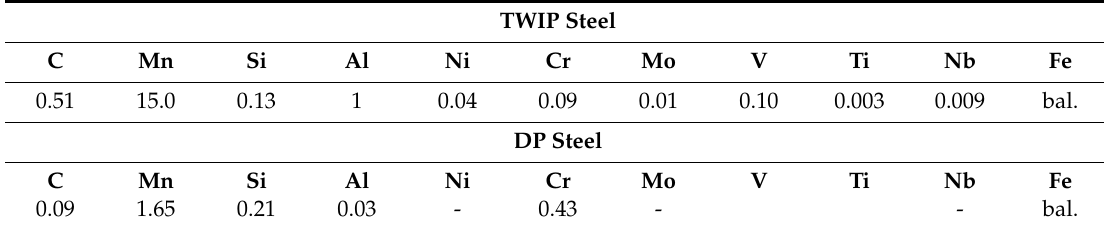
Table 1. Chemical composition of twinning-induced plasticity (TWIP) and dual phase (DP) steels (wt %) [20].